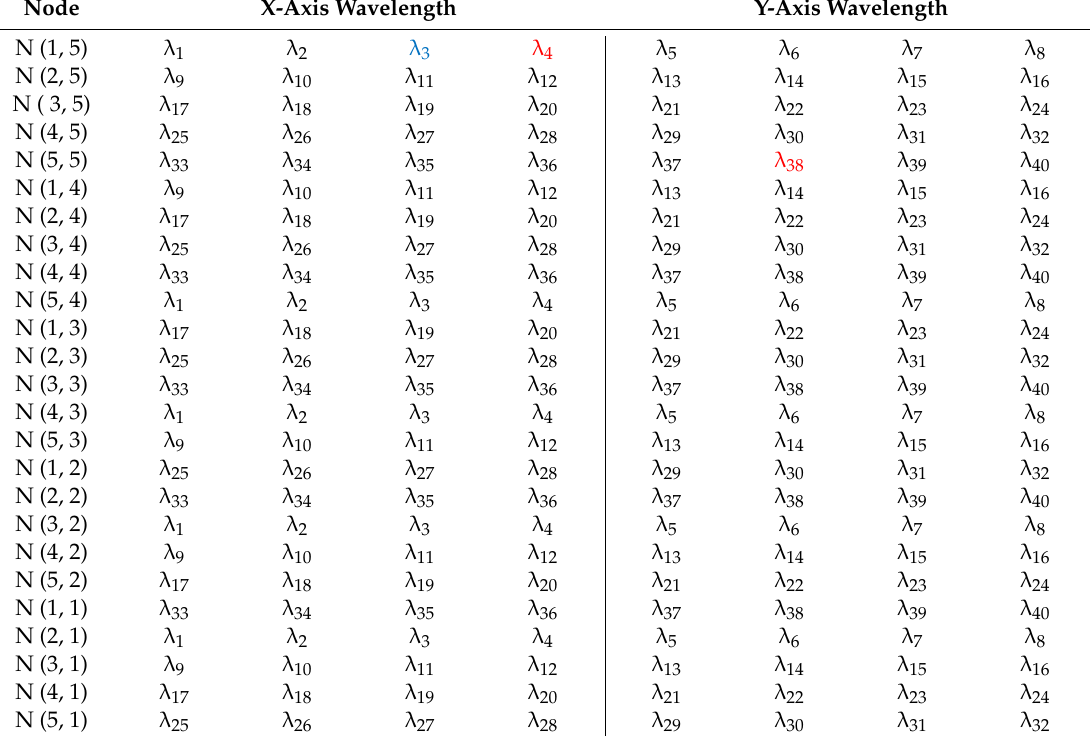
Table 1. X-axis and Y-axis wavelength assignment of each